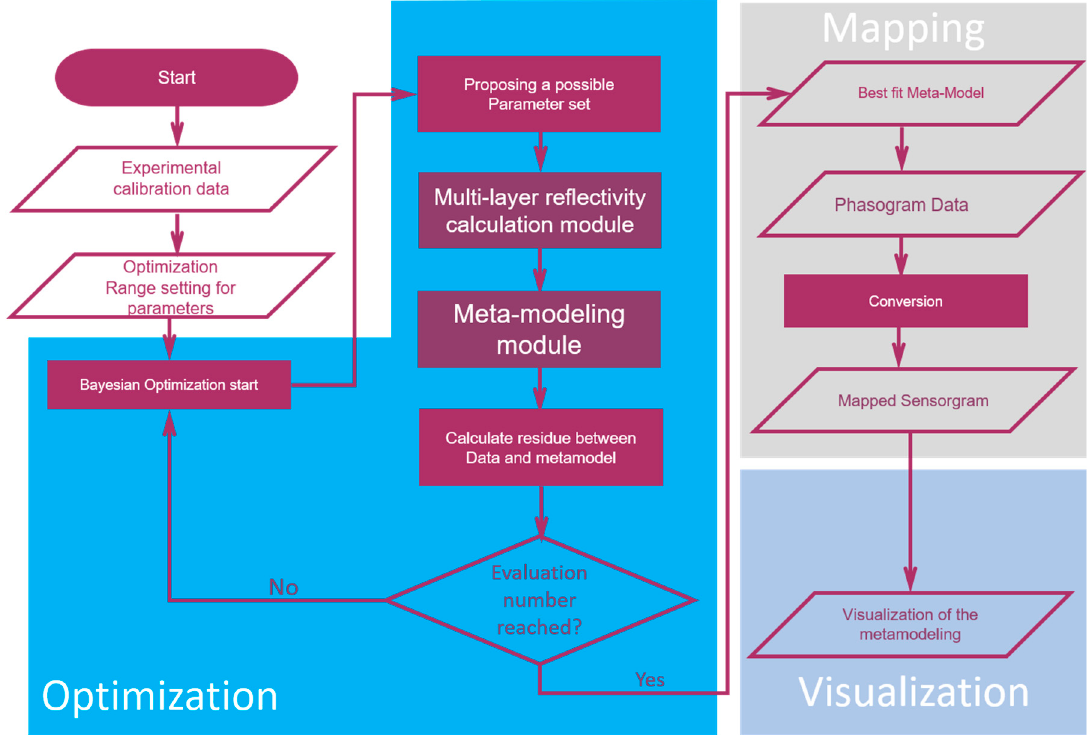
Figure 2. Algorithm flowchart.